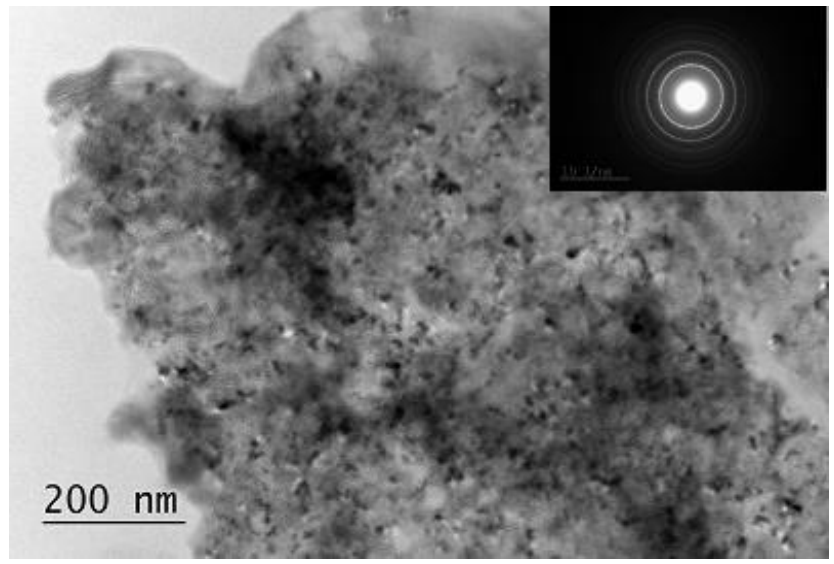
Figure 3. Transmission electron microscopy (TEM) image and bright field micrograph SAED pattern of the Mg 2.05 Ni 0.7 V 0.3 —5 wt.% ACAP after hydriding.